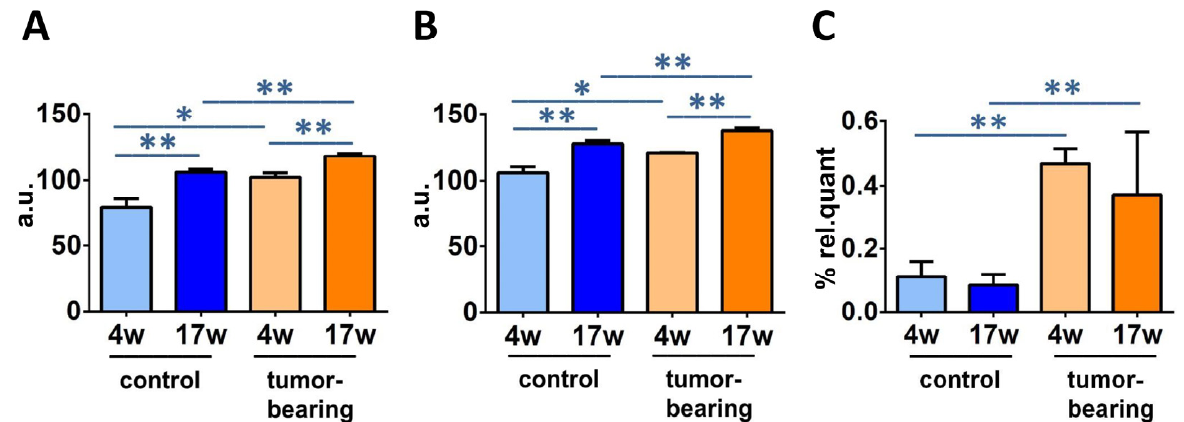
Figure 6. Significantly different fatty acid indices and families in SCID mice cohorts at different ages: ( A ) unsaturation index (UI); ( B ) peroxidation index (PI); ( C ) total TFA (for specific values, see Table 3). Significance: * ( p < 0.05), ** ( p < 0.01).